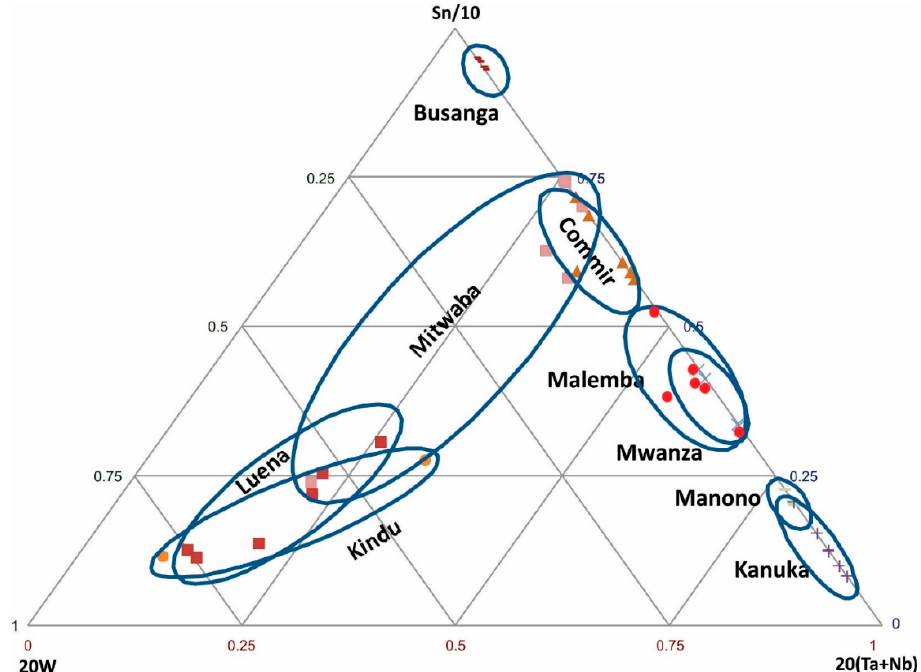
Figure 4. Discrimination of cassiterite samples from various regions based on Sn-W-(Ta + Nb).